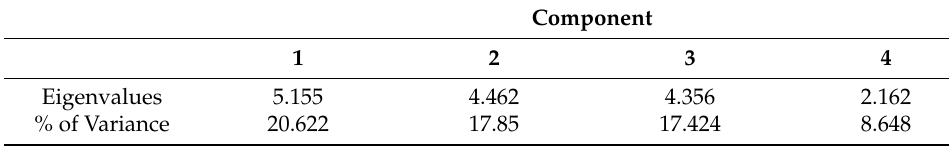
Table 5. Total variance and the Eigenvalues.